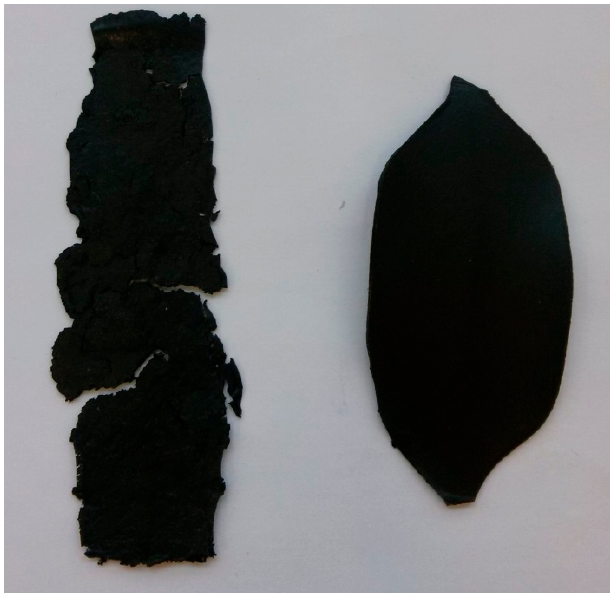
Figure 20. Materials MU2 ( left ) and MU3 ( right ) after pressing at same conditions.